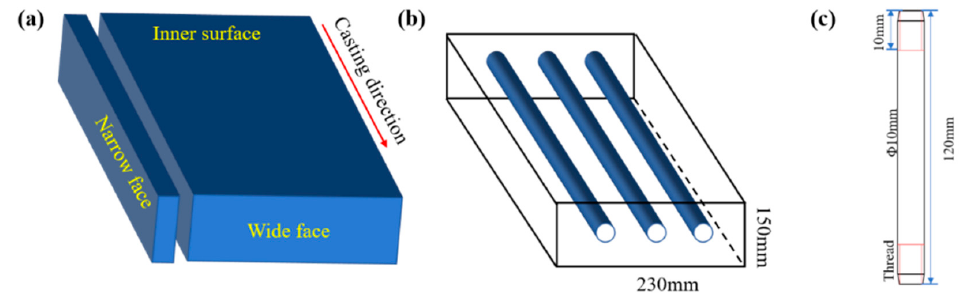
Figure 1. Schematic diagram of sampling and sample preparation. ( a ) Slab sampling location; ( b ) Sampling position of tensile specimen; ( c ) Schematic diagram of tensile specimen.